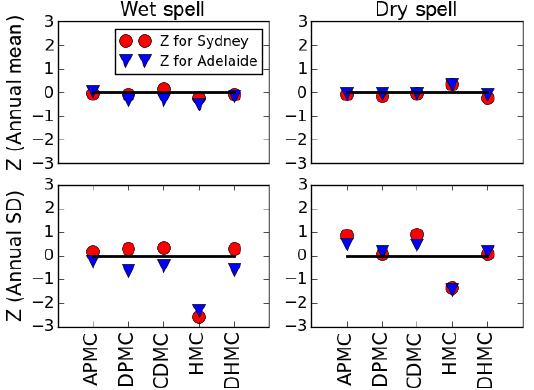
Figure 12. Comparison of the mean and SD of annual mean length of wet and dry spells for the five MC